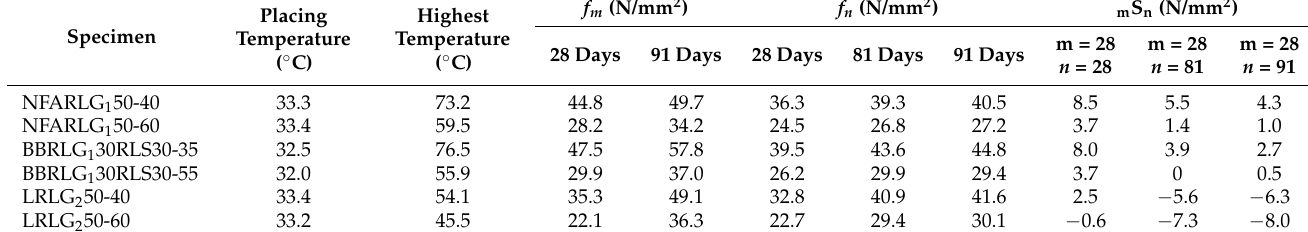
Table 9. Results of simple adiabatic curing method.